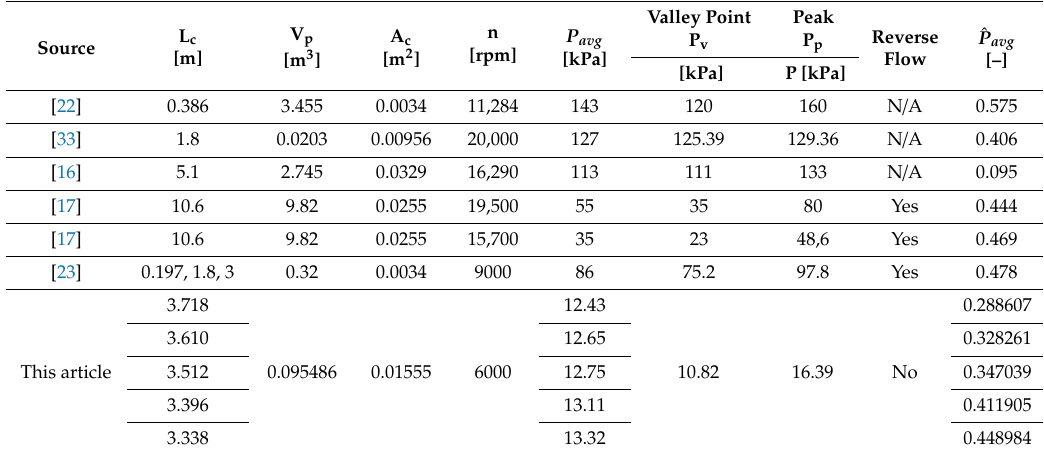
Table 1. Summary of data from articles concerning surge modelling in centrifugal